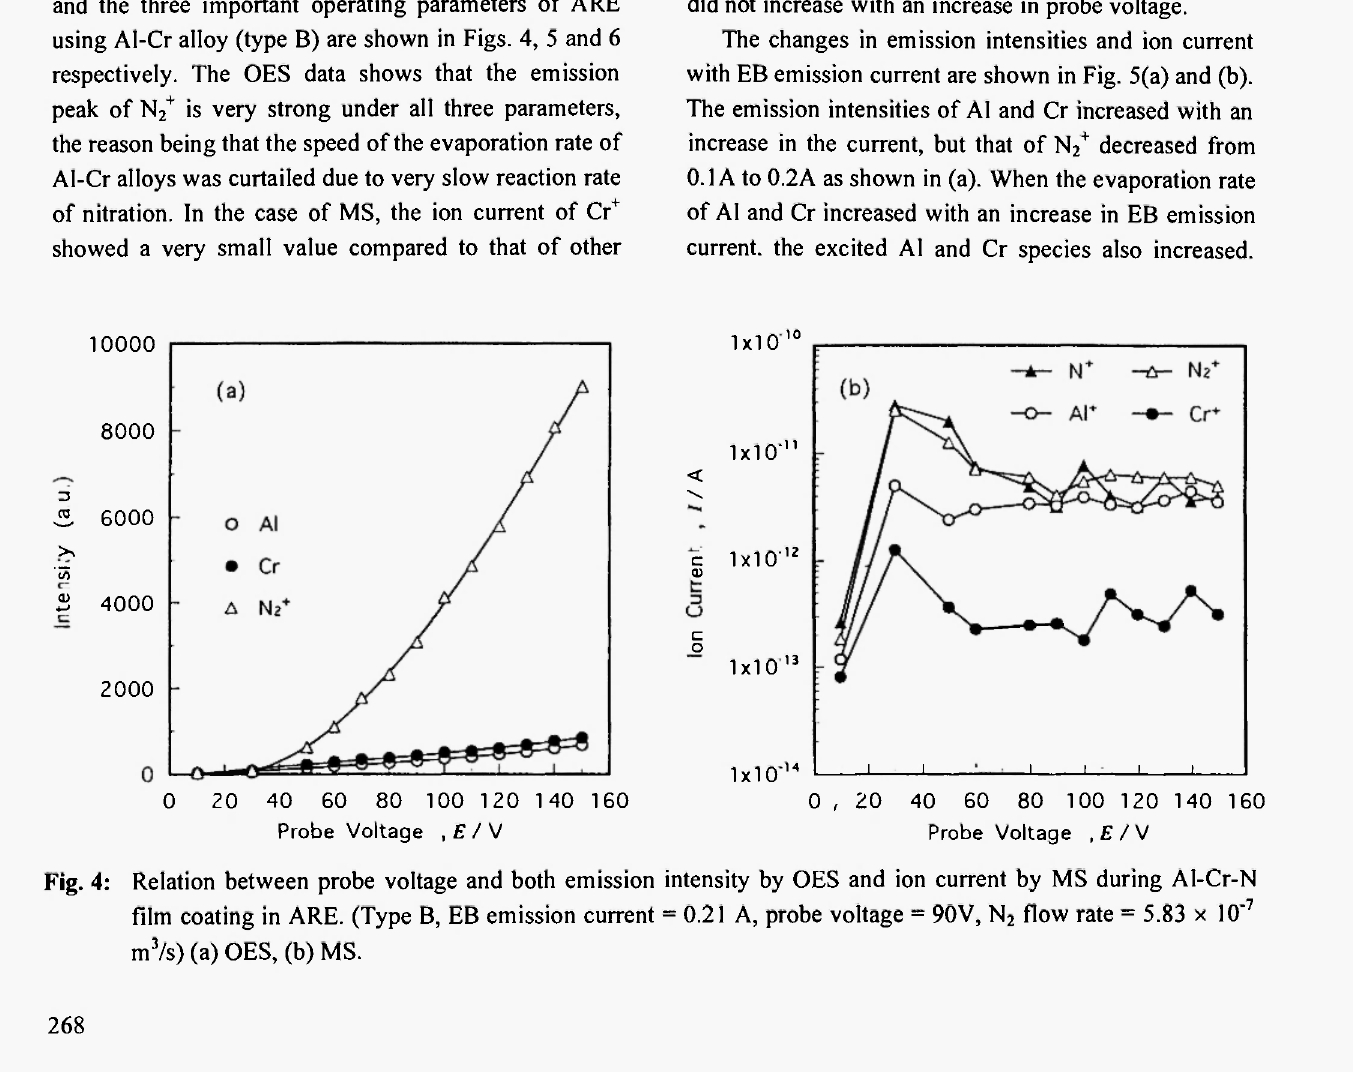
Fig. 4: Relation between probe voltage and both emission intensity by OES and ion current by MS during Al-Cr-N film coating in ARE. (Type B, EB emission current = 0.21 A, probe voltage = 90V, N 2 flow rate = 5.83 χ 10" 7 m 3 /s) (a) OES, (b)